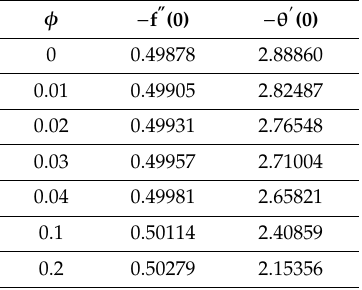
Table 2. The variation of the component of C f and Nu with φ ( m = 0.05, β = 0.05).